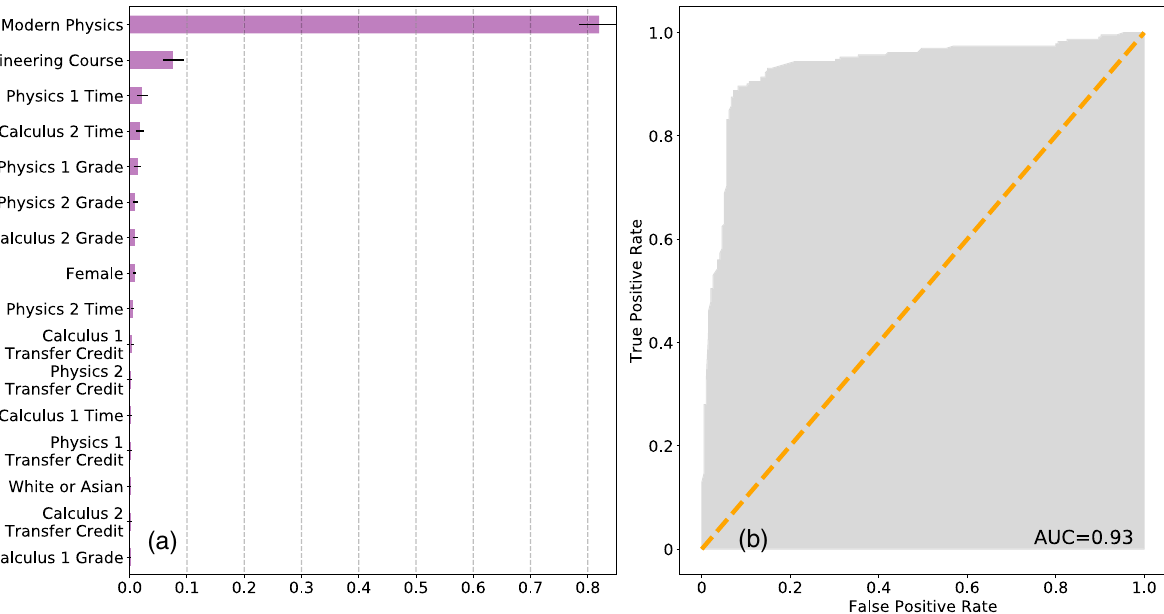
FIG. 3. (a) Feature importances for the main model. The error bars represent the standard error for the distribution of feature importances across all trees within the forest. (b) The ROC curve for the main model. The dashed line represents random